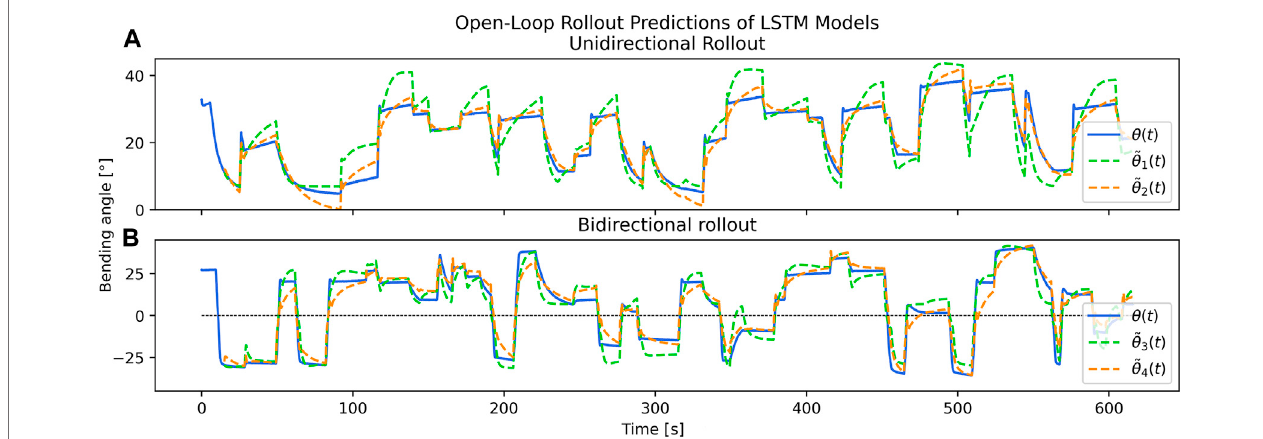
FIGURE6| Predicted rollout trajectories over 10 minofactuation using θ (t= 15s)asinitial value, forunidirectional (A) orbidirectional (B) motions. Test ~ θ 1 depicts a rollout from the model trained only on PWM input data on a single SMA. Test ~ θ 2 also depicts a unidirectional rollout, but uses the model trained on both PWM and temperature. Tests ~ θ 4 and ~ θ 4 show the rollouts for the bidirectional models trained on PWM and on PWM with temperature, respectively. All tests show extremely little drift over arbitrarily long time scales.